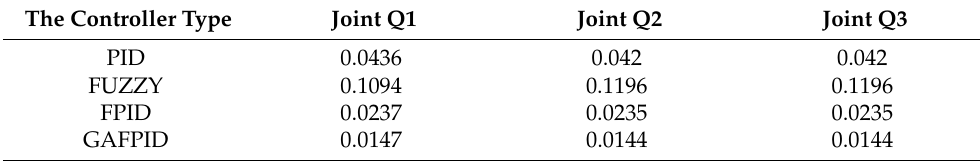
Table 7. IAE values.